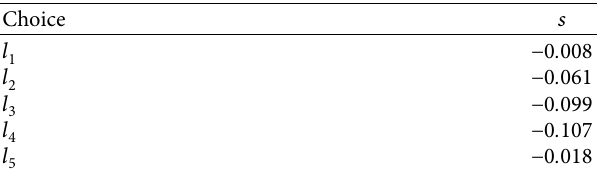
Table 6: Score function values against each choice.